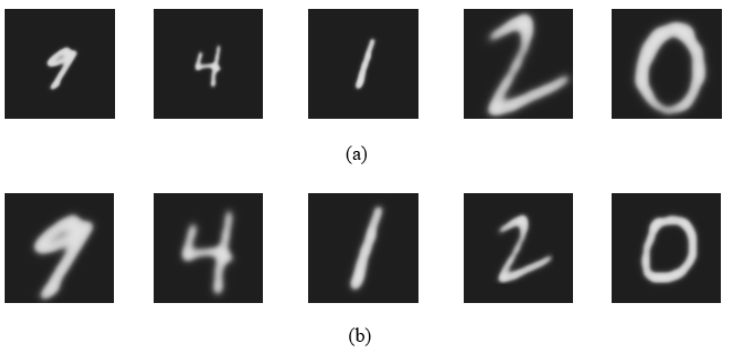
Figure 10. Visualization results of scale correction. ( a ) unknown-scale testing samples. ( b ) samples corrected to canonical scale.